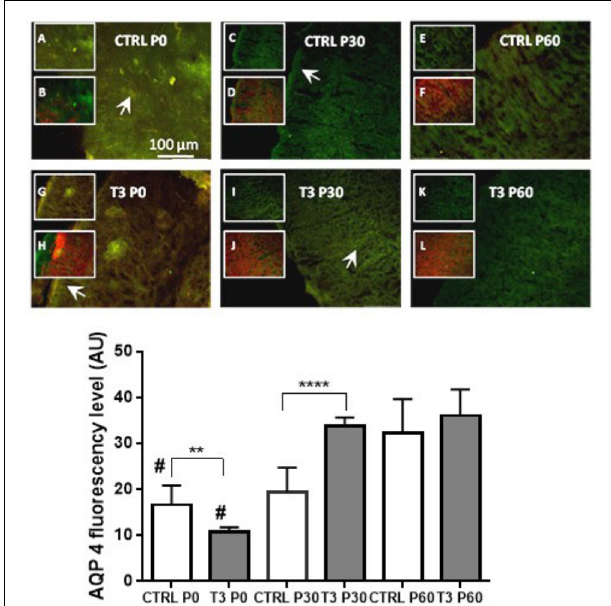
FIGURE 1 | (Upper) Aquaporin 4 (AQP4) distribution in the cerebral cortex of mice at postnatal days 0, 30, and 60 in control (CTRL) and T3-injected animals. Insets depict AQP4 immunoreactivity (green: A, C, E, G, I, and K) or merged GFAP (red) colocalization (B, D, F, H, J, and L). Immunoreactivity of AQP4 showed polarization to perivascular astrocytic end feet surrounding the cerebral microvessels (arrowheads in CTRL P0 and T3 P30) or in subpial astrocytes as depicted in CTRL P30 and T3 P0 slices. T3 injection caused an increase in AQP4 immunoreactivity with developmental progression. (Lower) AQP4 fluorescence levels in coronal sections of total brains. Mice treated with T3 showed higher levels of AQP4 from 30 to 60 days of age. N = 3 or 4 for each group; fluorescence analysis from 6 to 10 coronal sections of 40- µ m thickness. Student’s t -test; ∗∗ P < 0.01; ∗∗∗∗ P < 0.0001; # P < 0.0001 one-way ANOVA followed by Tukey’s test (CTRL P0 vs. CTRL P60; T3 P0 vs. T3 P30 and T3